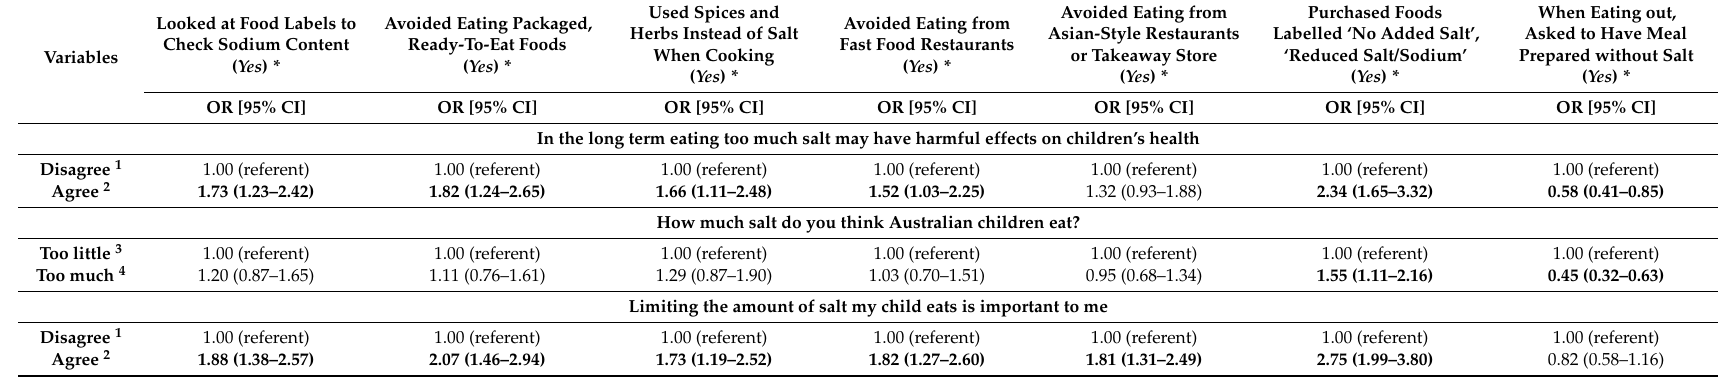
Table 2. Association of parents’ knowledge and attitudes related to their child/children with specific salt-related behaviours (logistic regression).